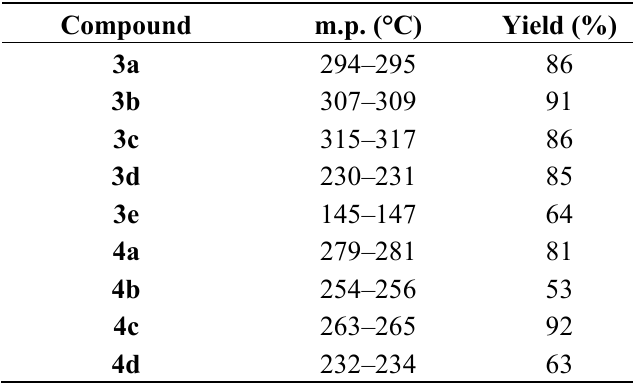
Table 1. Melting points and yields for the hetarylmethylidene rhodanine derivatives 3a – d , 3e and rhodanin-3-acetic acid derivatives 4a – d